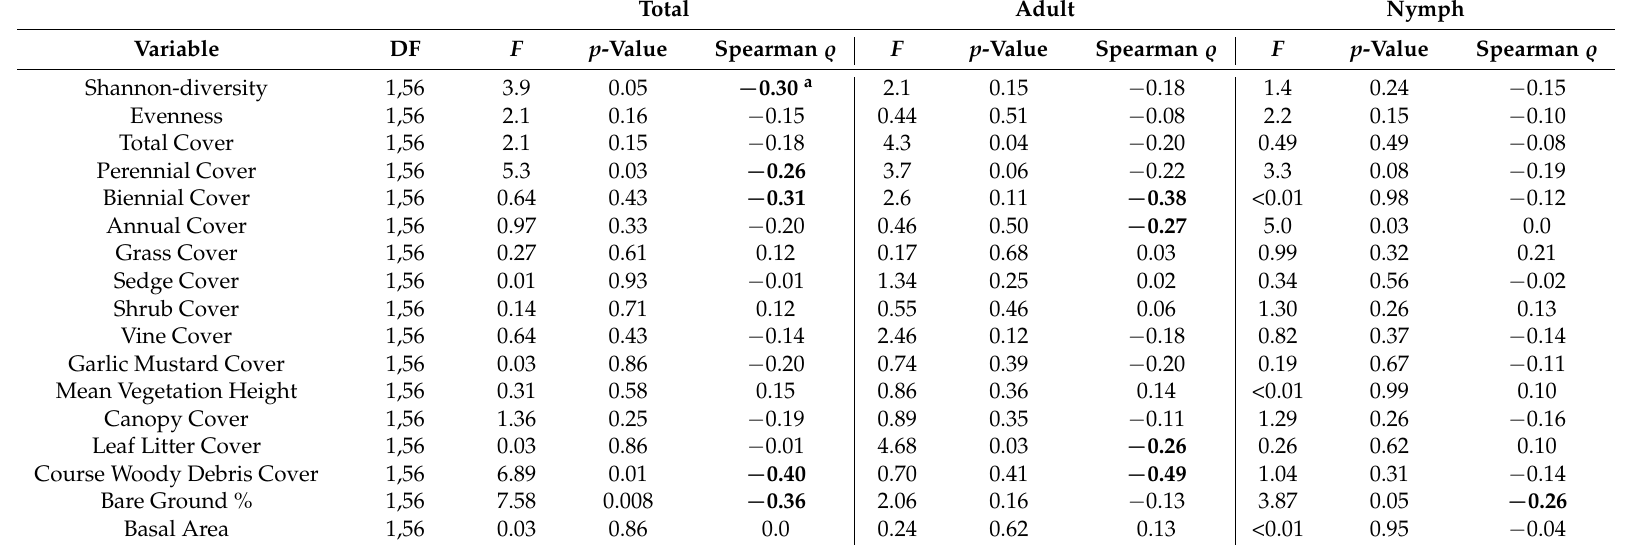
a Bold values indicate significant association ( p < 0.05) as indicated by Spearman rank